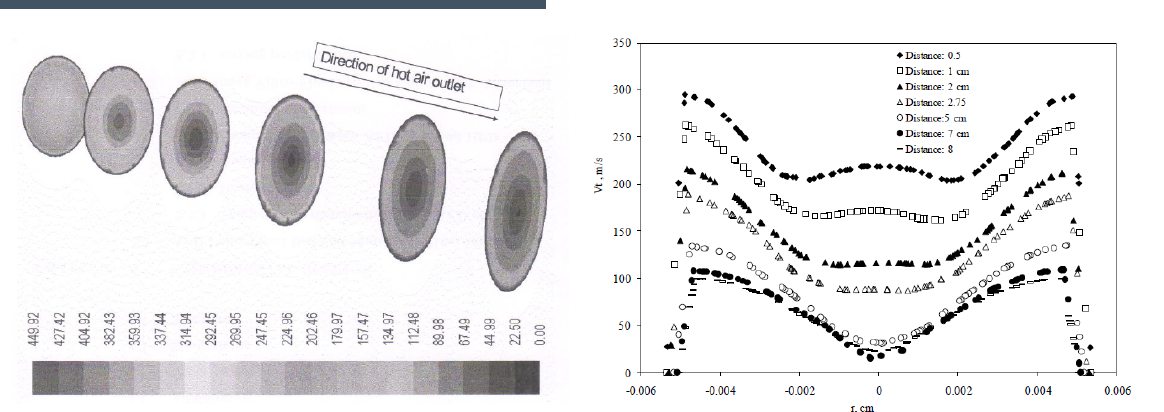
Figure 15. Contour of velocity magnitude (m/s) of hot end at RNG k-epsilon 5 bar.